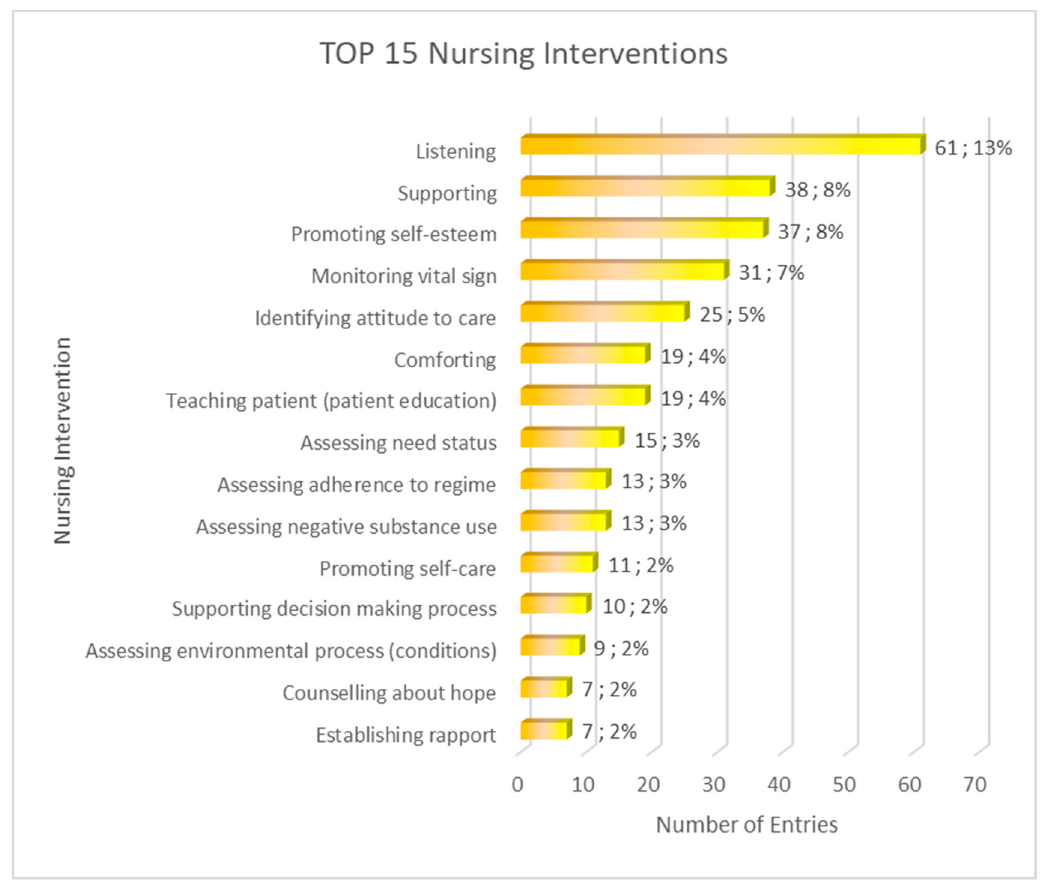
Figure 3. Number of entries and respective percentage (total = 455) of each nursing intervention included in the top 15 list, after recoding in accordance with the 2019’s version of the ICNP. Other nursing interventions also deserve to be highlighted, although they reveal lower percentage values: “comforting” (19; 4%); “patient education” (19; 4%); “assessing need status” (15; 3%); “assessing adherence to regime” (13; 3%); “assessing negative substance use” (13; 3%); “promoting self-care” (11; 2%); “decision-making support” (10; 2%); “assessing environmental conditions” (9; 2%); “counseling about hope” (7; 2%); and “establishing rapport” (7; 2%).